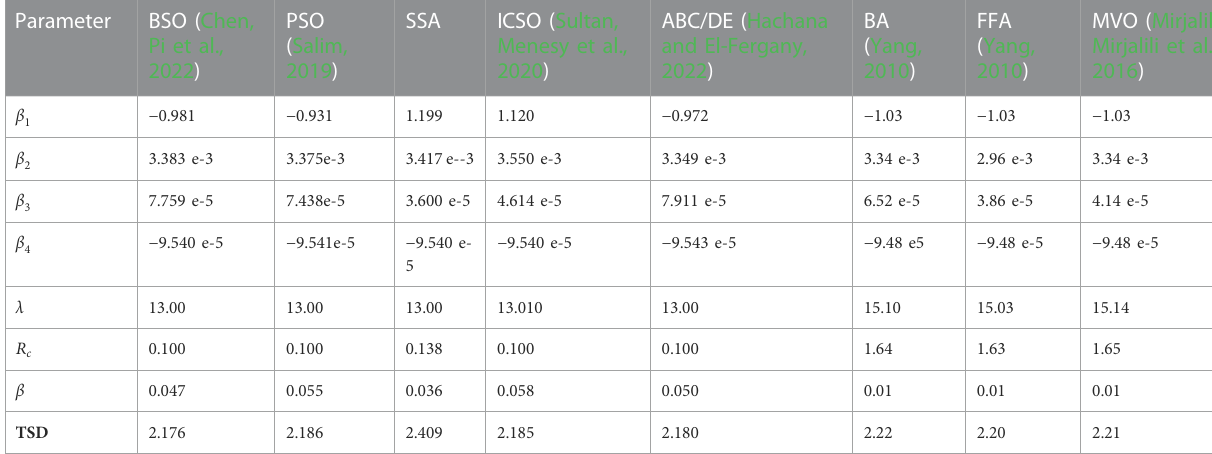
TABLE 3 TSD assessment of the NedStack